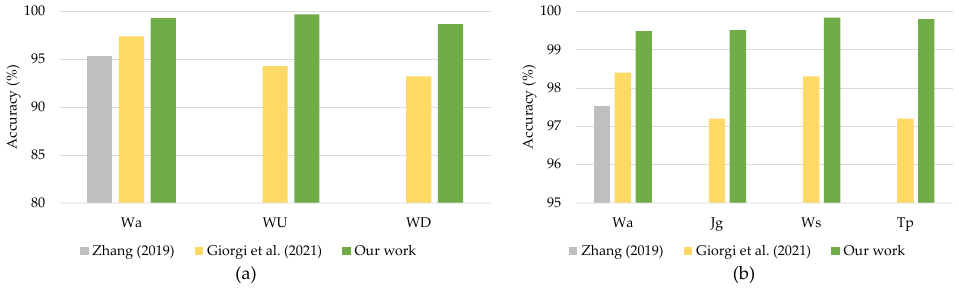
Figure 11. Comparison with previous works on ( a ) UCI-HAR dataset and ( b ) WISDM-HARB dataset.